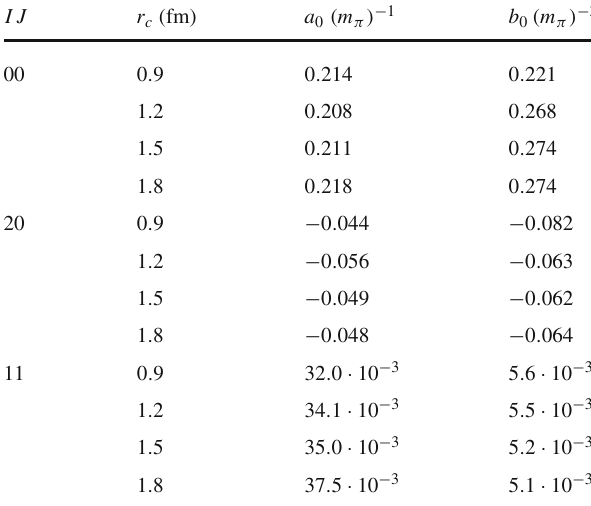
Table 7 Scattering lengths and slope parameters for the different fits including the TPE chiral tail with an increasing number of delta shells separated by r = 0.3 fm